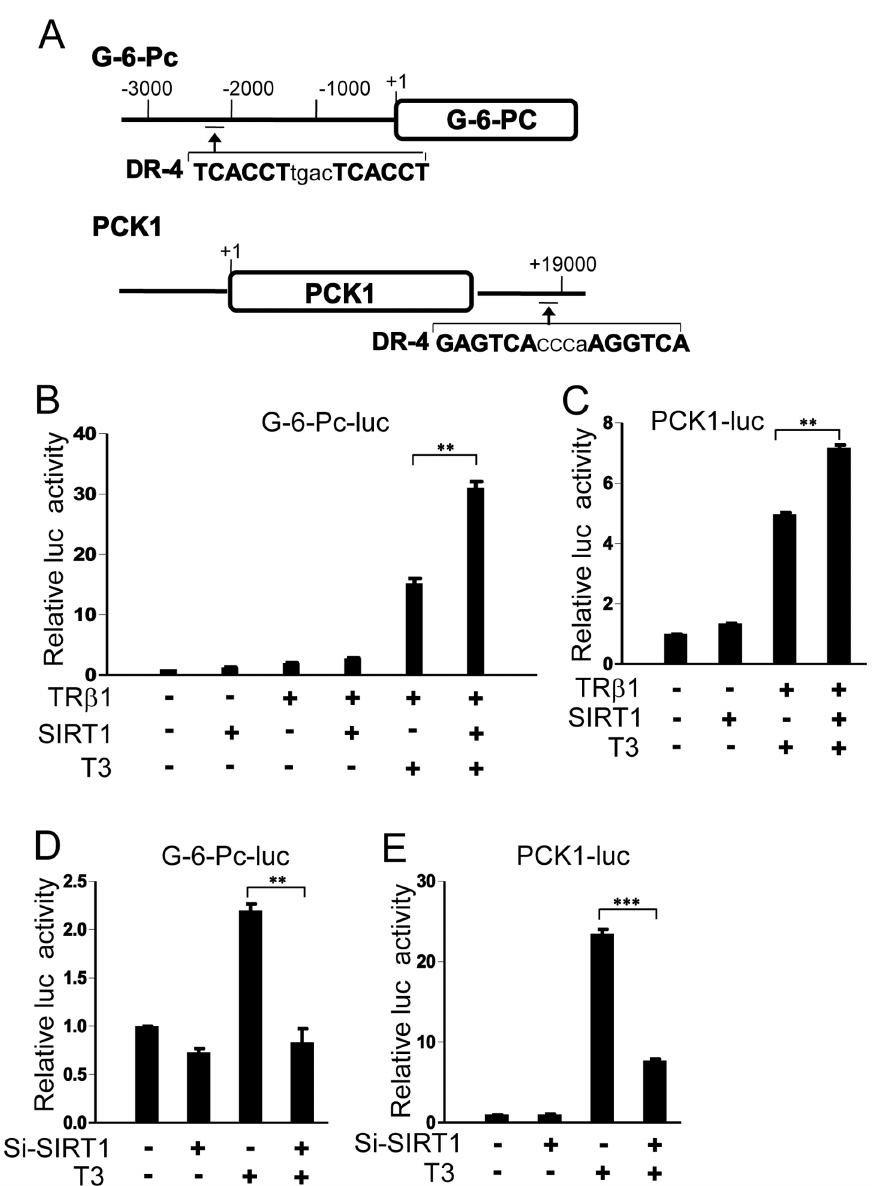
Figure 8. SIRT1 regulates TR b 1 target gene promoter activity. ( A ) Schematic representation of TR b 1 response regions (TREs) of TR b 1 target genes with sequences and positions of DR-4 sites for G-6-Pc gene and PCK1 gene. (B–C) Luciferase assays performed on extracts of 293T cells that were cotransfected with indicated reporters along with TR b 1 and SIRT1 expression vectors and treated + / 2 T 3 . (D, E) Luciferase assays performed on extracts of HepG2-TR b 1 cells transfected with indicated reporters and SIRT1 siRNA and treated + / 2 T 3 . The levels of luciferase activity were normalized to the lacZ expression. Data are representative of at least three independent experiments with similar results. All values represent mean 6 SD of duplicate samples. **, P , 0.01; ***, P ,